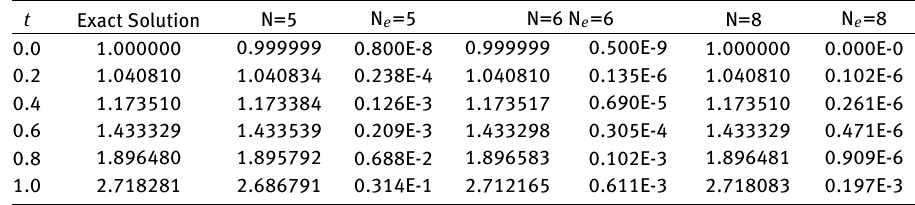
Table 1: Numerical result for approximate solution of y 1 ( t ) in Example 2.